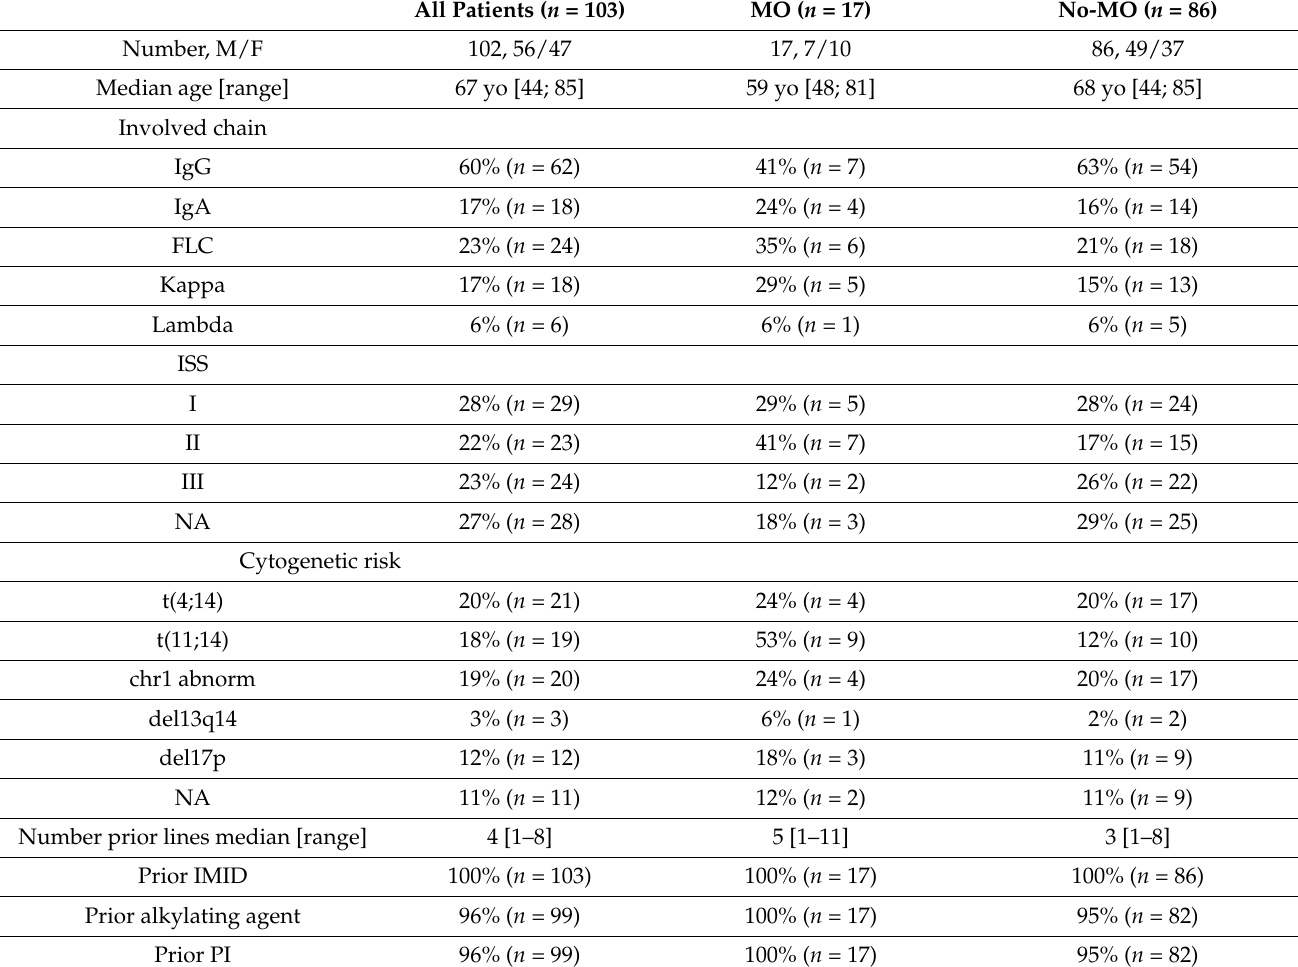
Table 1. Descriptive characteristics of the cohort and two treatment